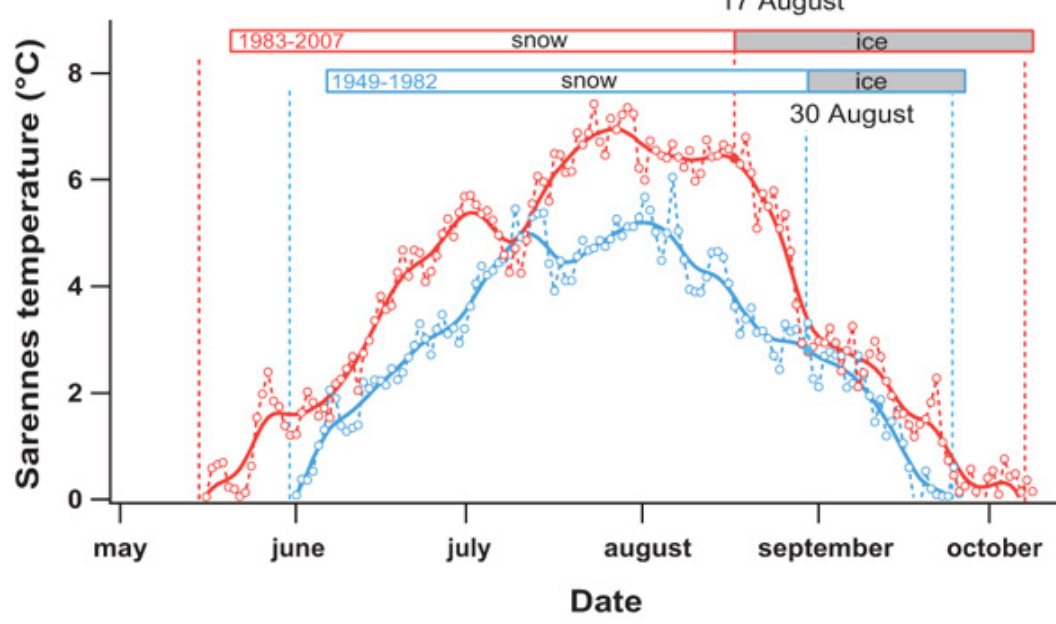
Fig. 12. Mean daily temperature above 0 ◦ C at Sarennes (3000m) between 1949–1982 (blue curve) and 1983–2007 (red curve), explaining the lengthening of the ablation season with earlier snow melt in May, earlier ice melt in August and later ice melt in October according to the PDD model. Dashed lines and markers are raw daily means while continuous lines are Gaussian smoothed daily means. Horizontal bars are measured average ablation durations at stake 4 for snow (white) and ice (grey) for the two periods.